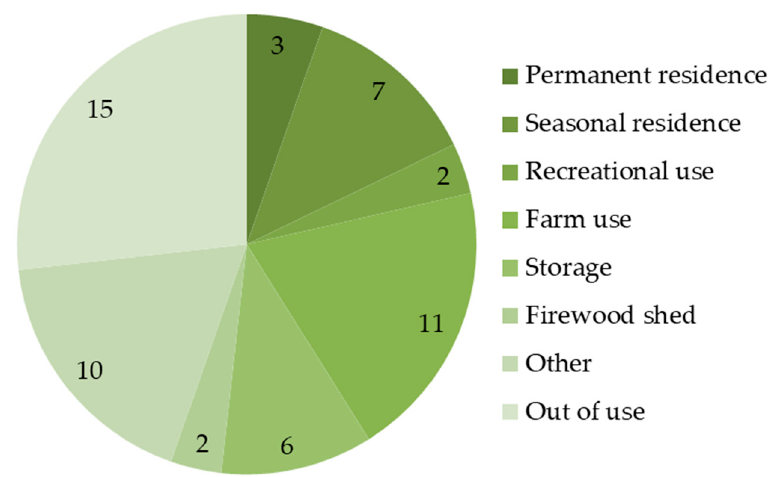
Figure 7. Registered use of the 56 intact buildings at Havrå (19 ruins are excluded).